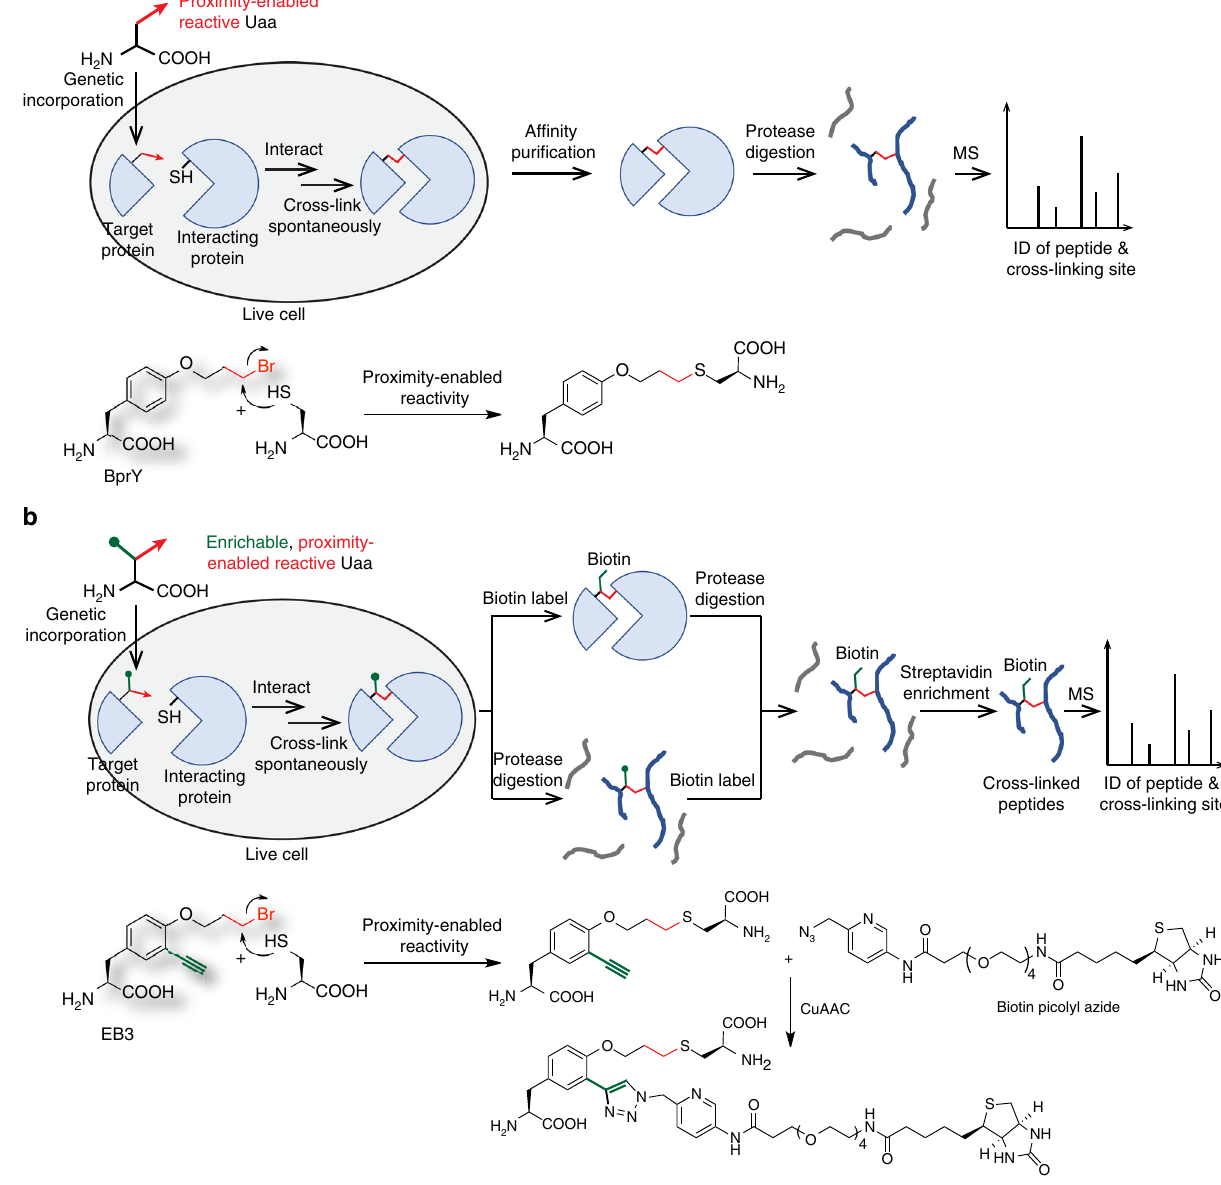
Fig. 1 GECX to capture protein interactions in live cells for MS identi fi cation. a Schematic illustration of the GECX-MS strategy. The Genetically Encoded Chemical Cross-linking (GECX) Uaa has proximity-enabled reactivity, which speci fi cally reacts with the target residue (e.g., Cys) of interacting proteins only when the two proteins interact and place the Uaa in proximity to the target residue. The resultant covalent linkage captures interacting proteins in situ for subsequent identi fi cation with Mass Spectrometry (MS). The structure of the chemical cross-linking Uaa BprY and its reaction with Cys are shown at the bottom. b Schematic illustration of GECX-MS using the enrichable chemical cross-linking Uaa EB3. Structure of EB3 and its reaction with Cys via proximity-enabled reactivity, followed by labeling with biotin through the click chemistry CuAAC are shown at the